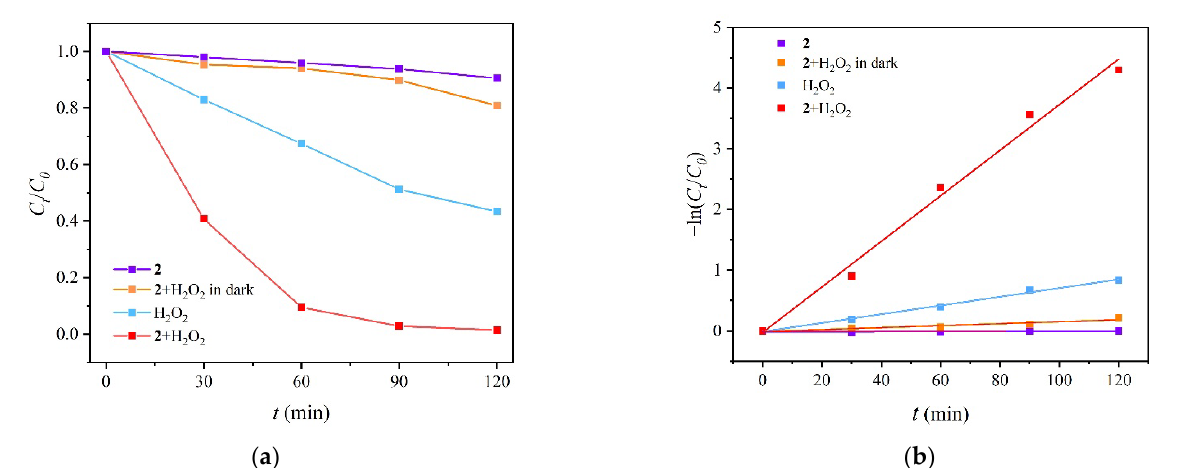
Figure 4. The concentration of RhB ( a ) and pseudo-first order kinetic curves ( b ) with varied reaction time.